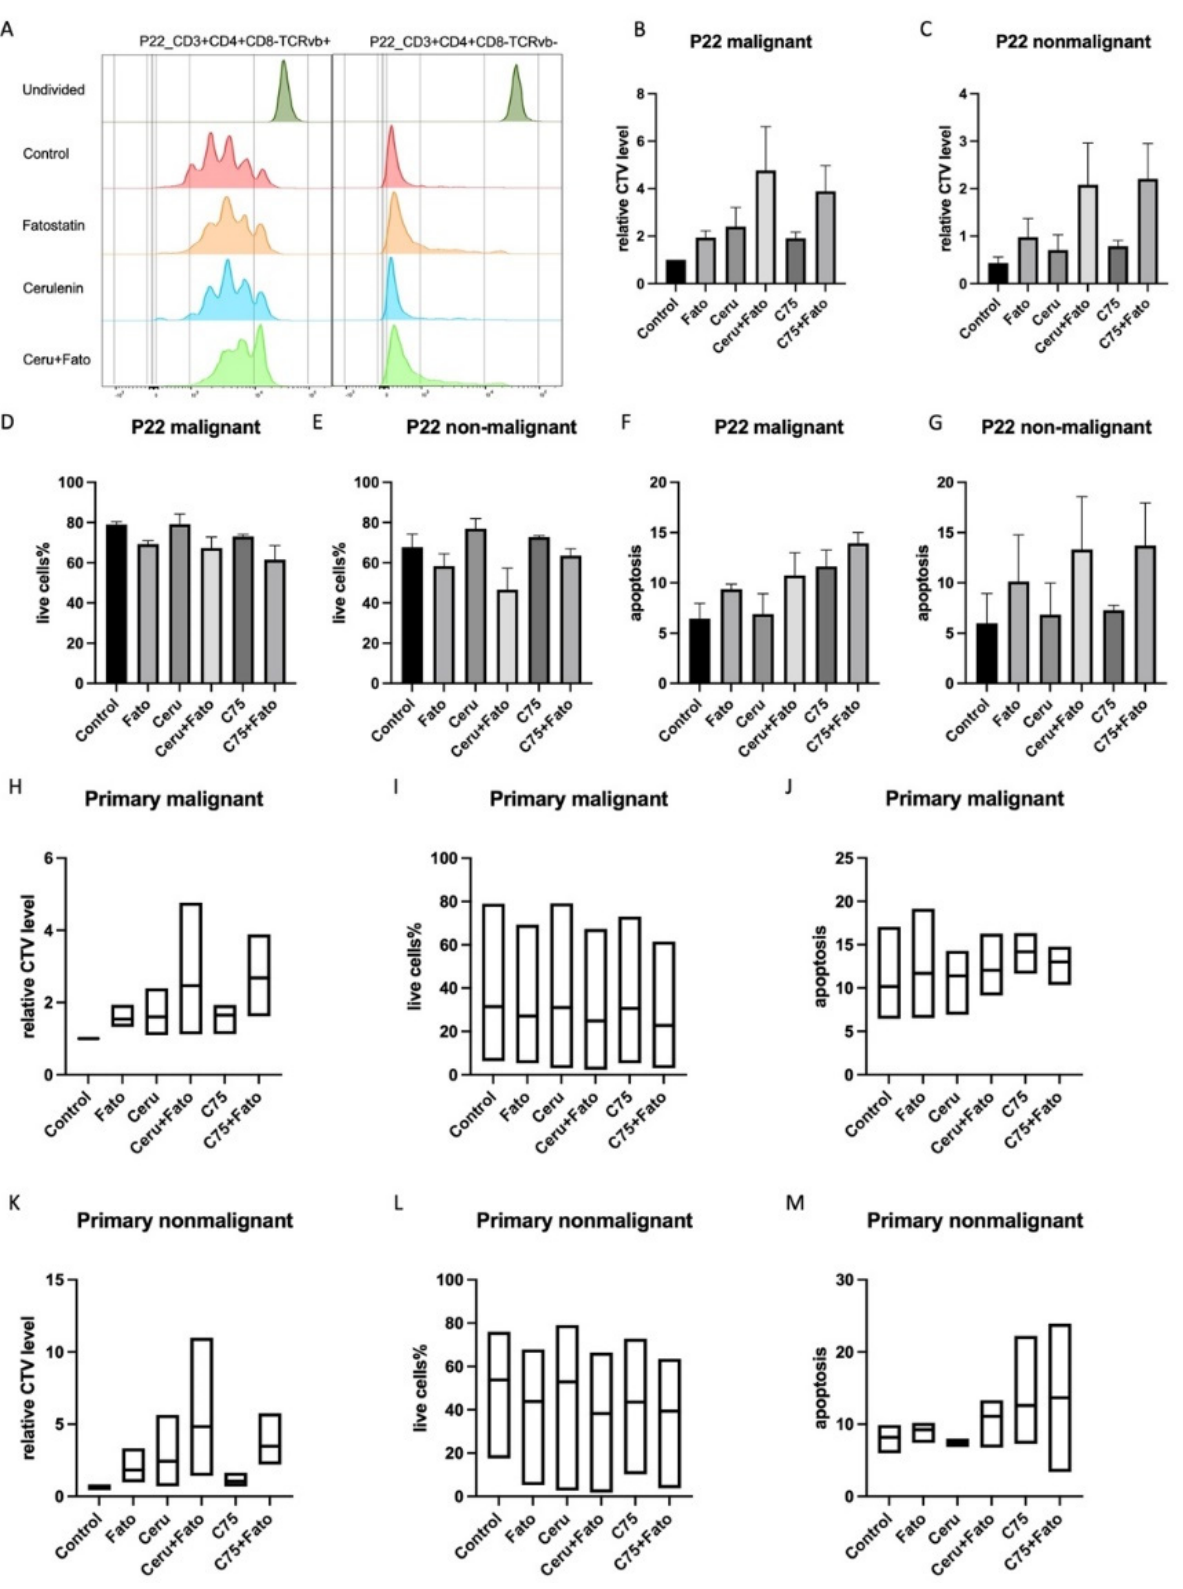
Figure 6. The effects of FASN and SREBP inhibitors in primary cells. ( A – G ) reveal the effects of FASN and SREBP inhibitors on patient 22. ( H – M ) are the collective data of patient P22, P6, and P16. Statical significance testing was performed with a one-way ANOVA (Tukey´s multiple comparison) test described in materials and methods.